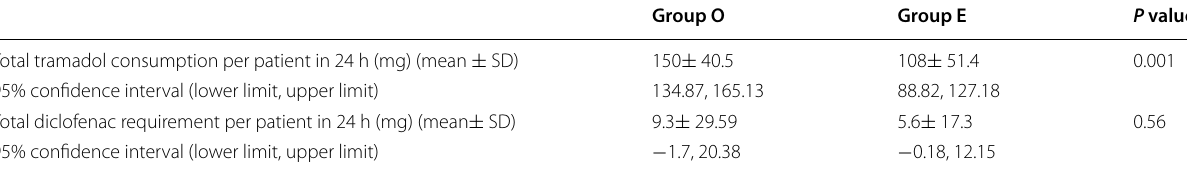
Table 3 Rescue analgesic requirements of the two groups